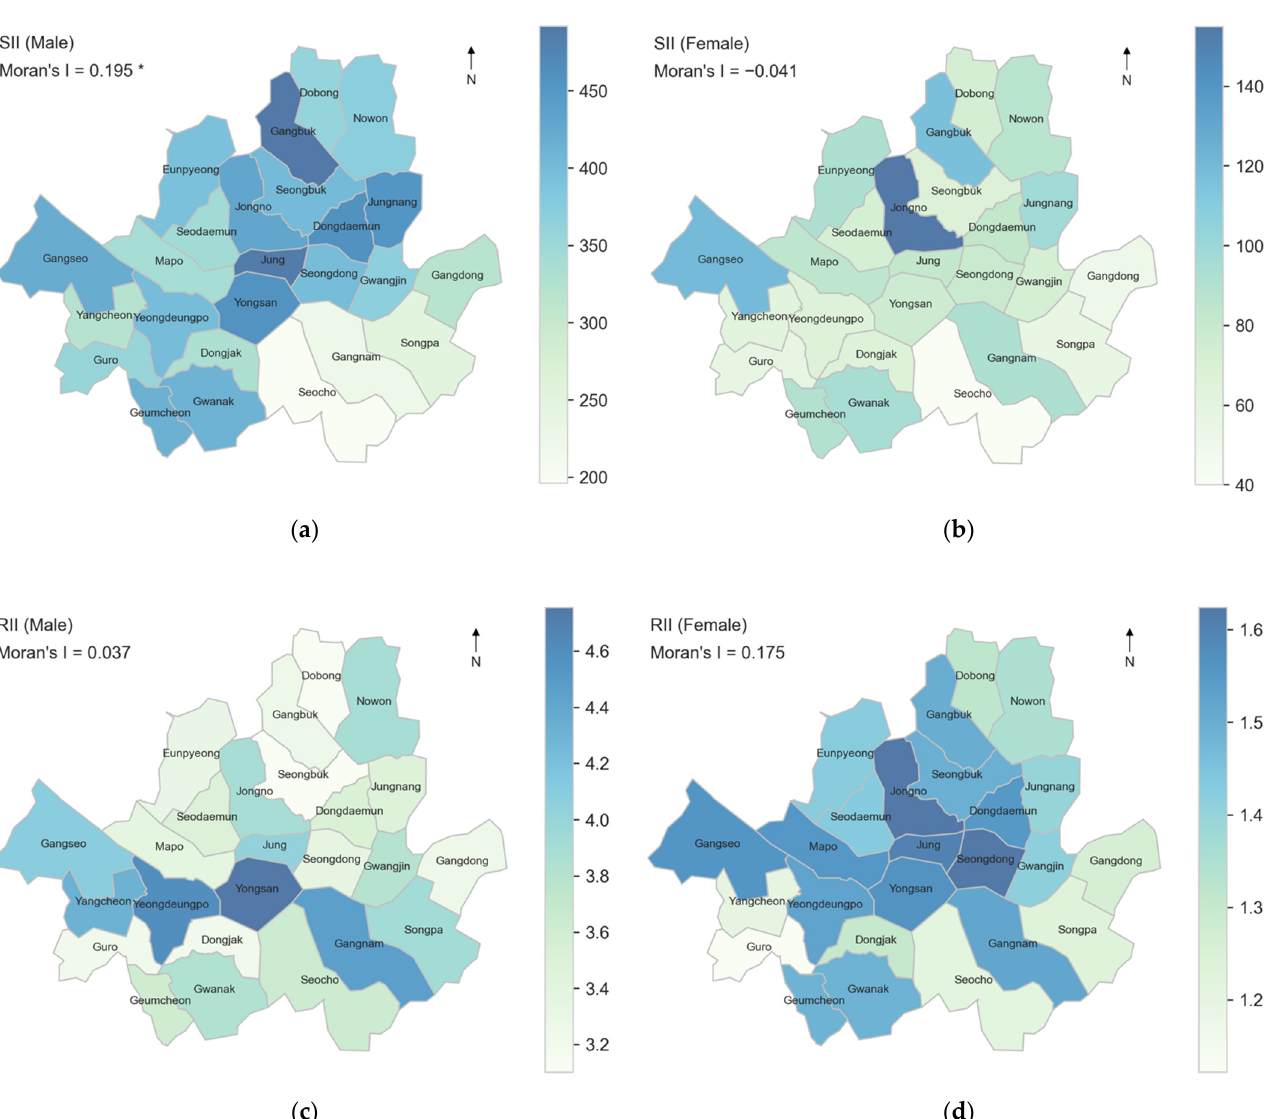
Figure 3. SIIs and RIIs by income quintile in 25 districts in Seoul for the period from 2014 to 2018 for men (left) and women (right) aged 45+. Weights used in computing Moran’s I are based on rook contiguity: ( a ) SII among men (per 10,000 people); ( b ) SII among women (per 10,000 people); ( c ) RII among men; ( d ) RII among women. *** p < 0.001, ** p < 0.01, * p < 0.05.